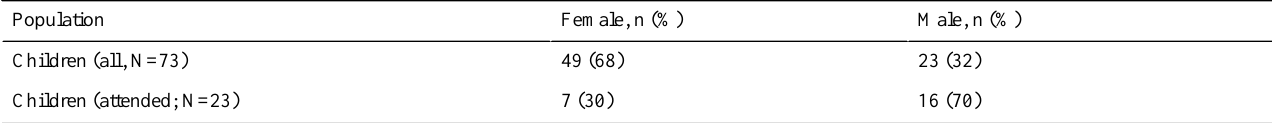
Table 3. Gender of children.